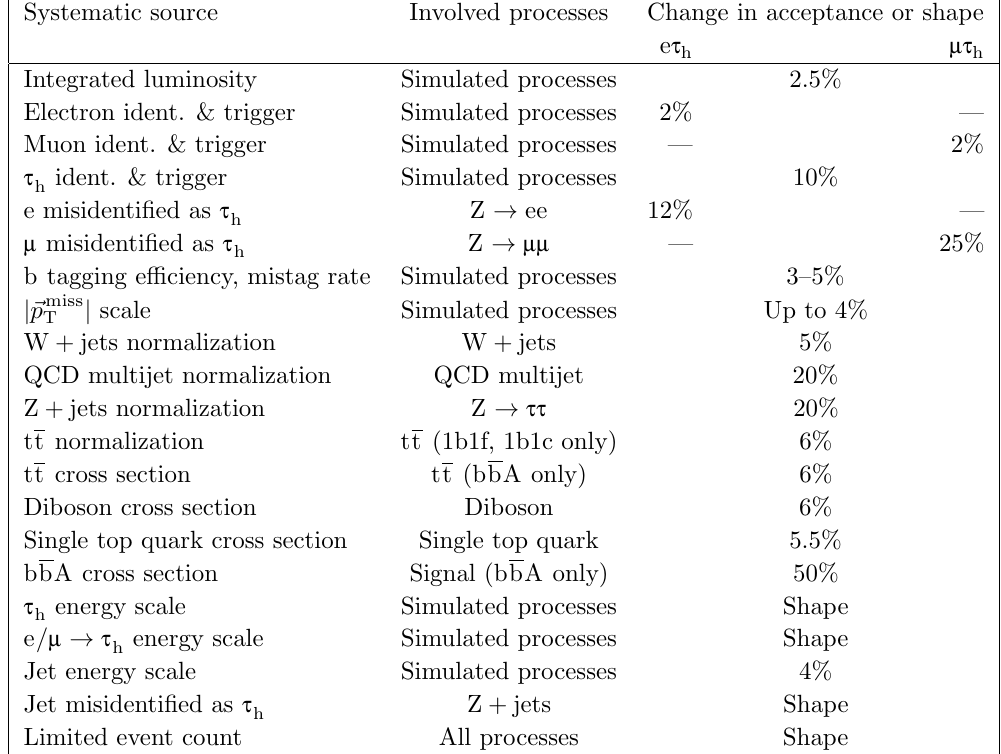
Table 1 . Sources of systematic uncertainties and their e(cid:11)ects on the acceptance or shape resulting from a variation of the nuisance parameter equivalent to one standard deviation.